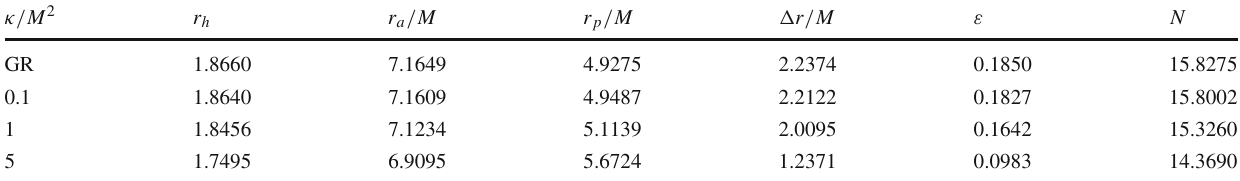
Fig. 5 The dependency between the orbital parameters and the devia- tion parameter